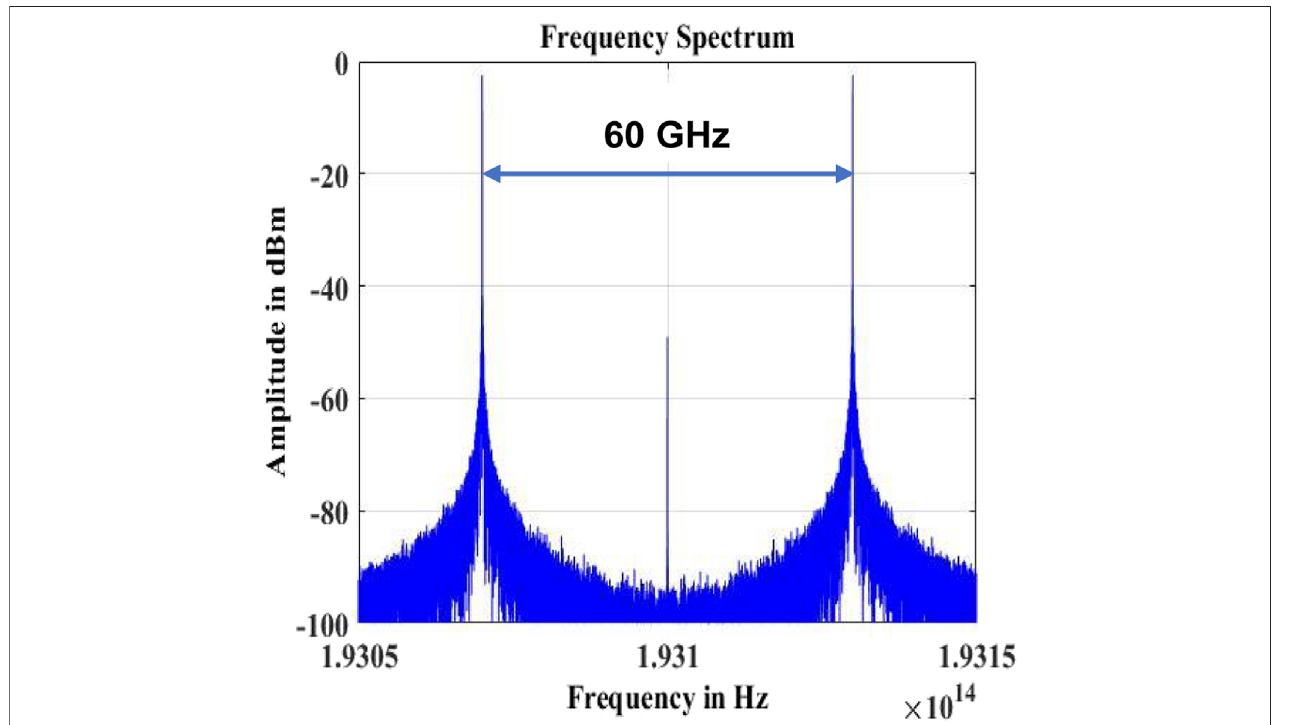
FIGURE 3 | 193.07 THz LOO and 193.13 THz UOO Frequencies generation using frequency quadrupling.